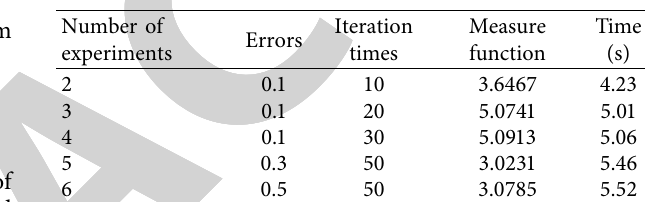
Figure 4: Image fusion process based on IHS transform and lifting wavelet transform. Table 1: The experimental data.